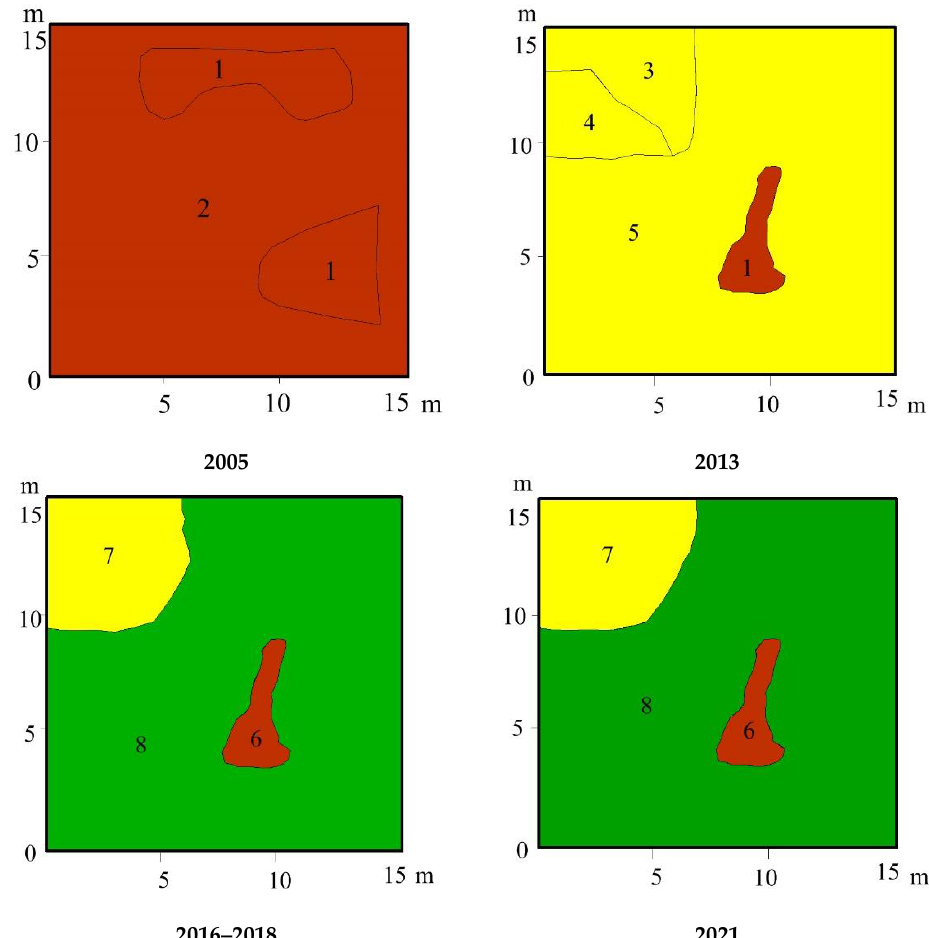
Figure 12. Changes in vegetation on permanent plot No. 2: 1 bare peat; 2 Betula pubescens – Chamаenerion angustifolium – Ceratodon purpureus ; 3 C. angustifolium ; 4 Calamagrostis epigejos ; 5 C. angustifolium + C. epigejos – C. purpureus ; 6 curtains of Polytrichum juniperinum ; 7 C. epigejos + C. angustifolium ; 8 B. pubescens + Populus tremula .